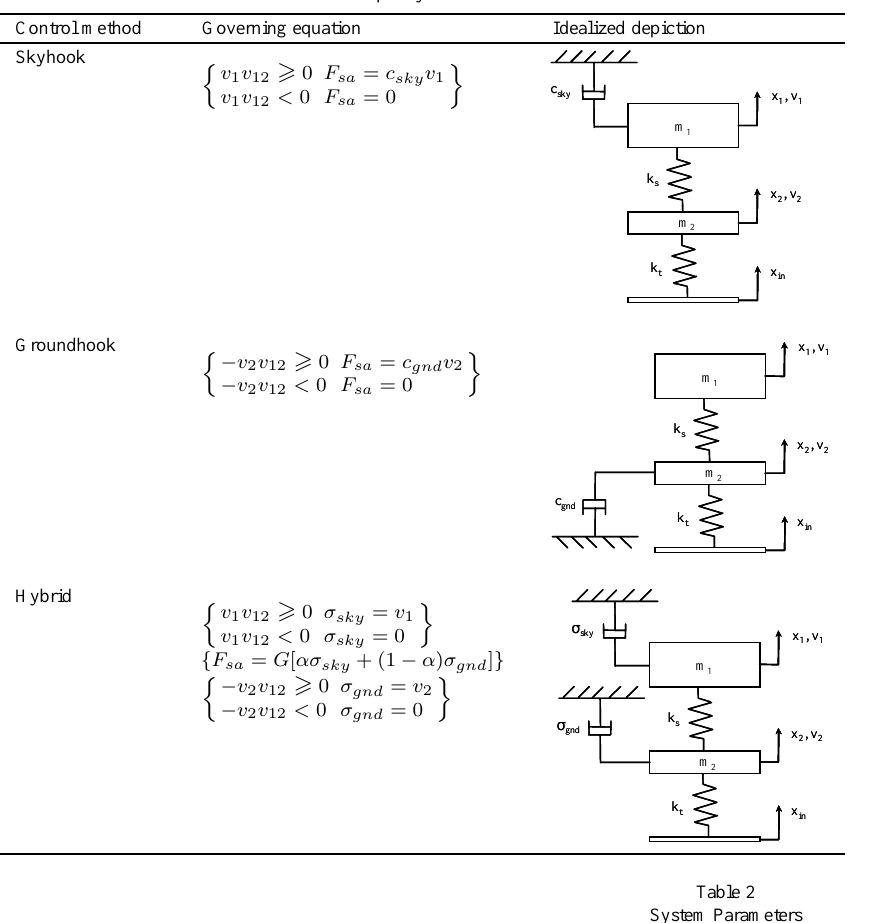
Control method Governing